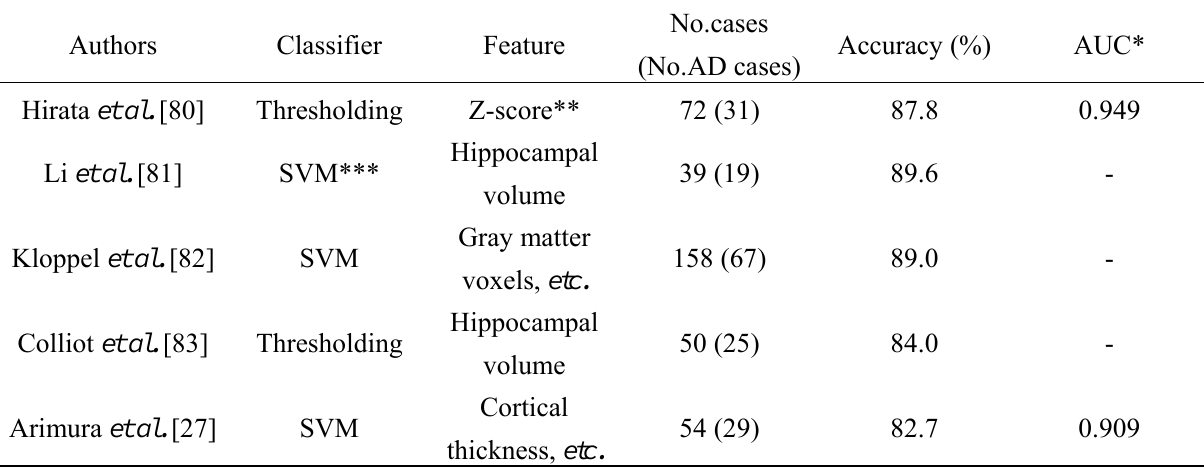
Table 3. Comparison of methods and performance of CAD systems for Alzheimer's disease using MR images.